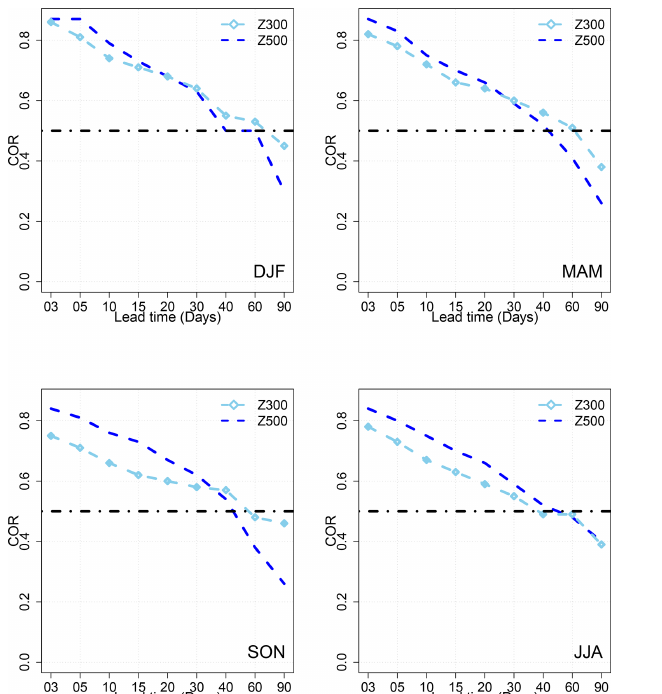
Figure A1. COR values for different lead times of forecasts from 3 to 90d over the period from 1979 to 2020 for the SWG forecast based on analogs of Z500 and Z300 for different seasons (DJF, JJA, MAM, and SON).